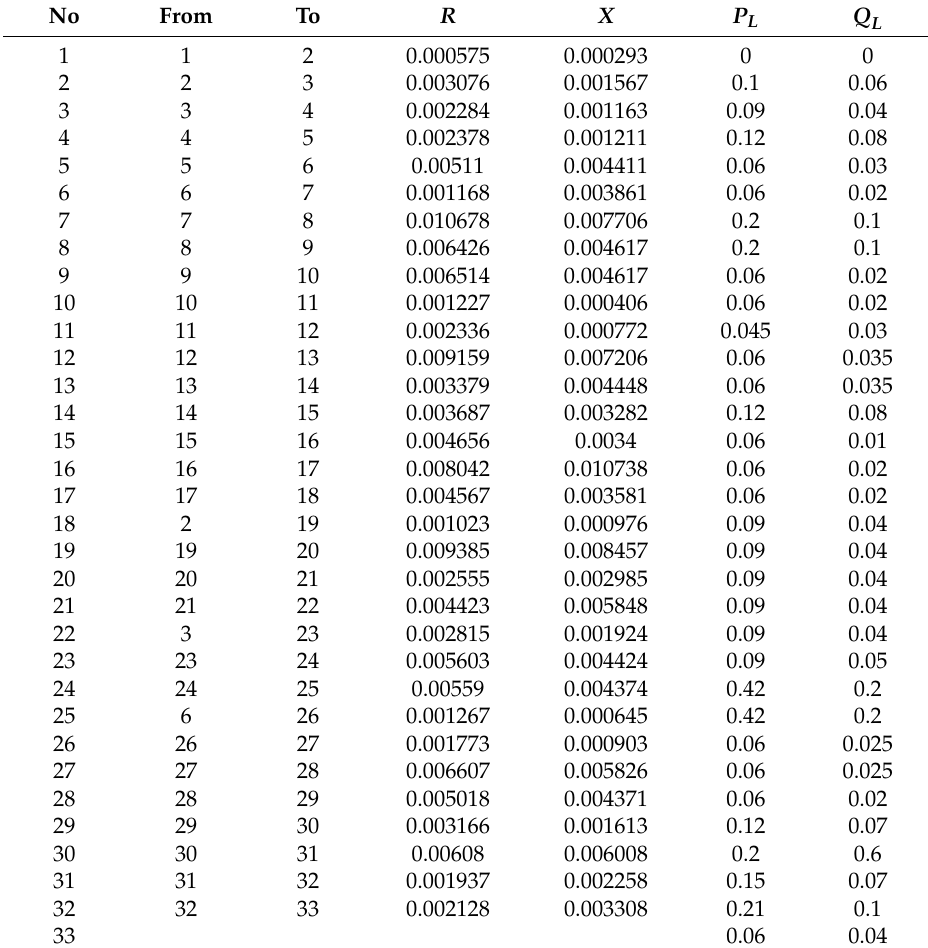
Table A1. Bus and branch data for IEEE 33 radial distribution system.